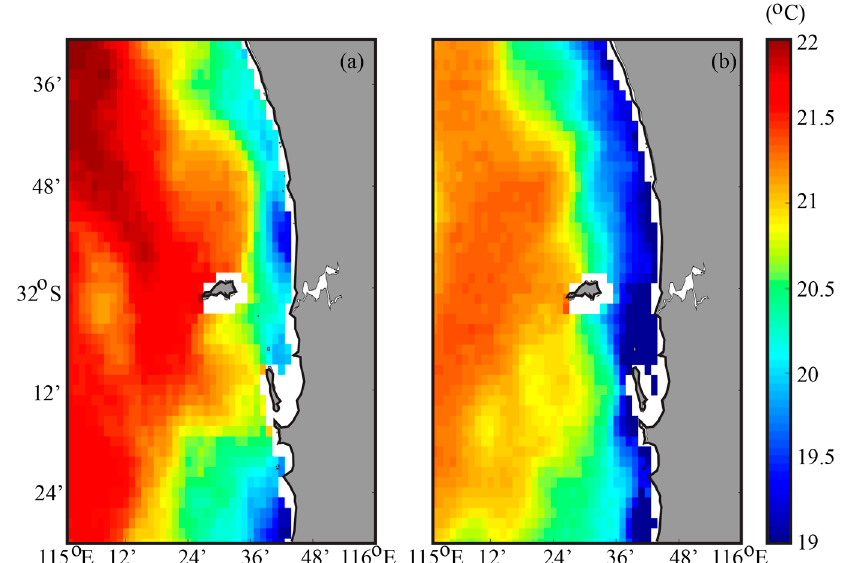
Figure 3. Satellite-derived 3-day mean sea surface temperature: ( a ) May 9–11, 2016, before the major storm event; and ( b ) at the end of the study period for June 1–3, 2016. Note the overall cooler temperatures and narrow band of cooler waters near the coast.